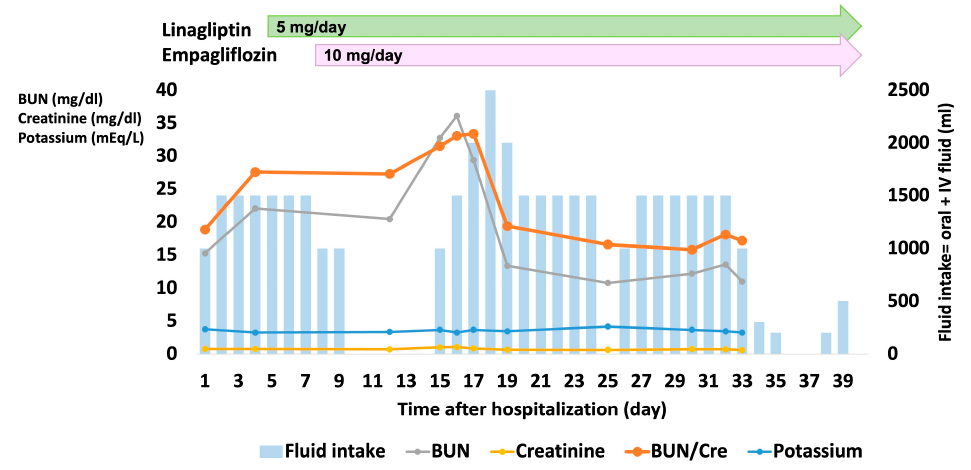
Figure 2. Clinical course during hospitalization. BUN—blood urea nitrogen; BUN/Cre—blood urea nitrogen/creatinine, IV: intravenous.